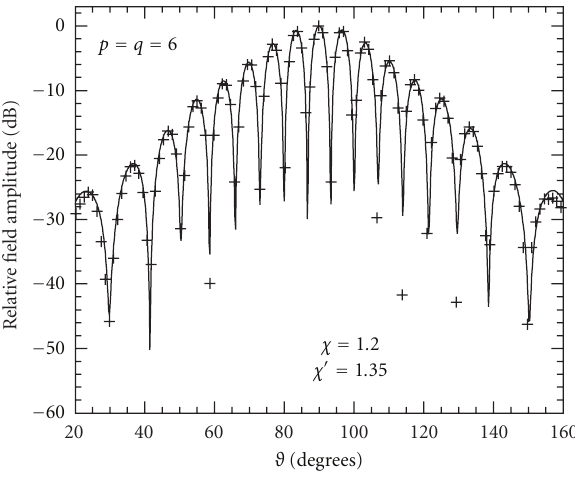
Figure 20: E-plane pattern. Solid line: reference. Crosses: recon- structed from NF data acquired via the helicoidal scanning.